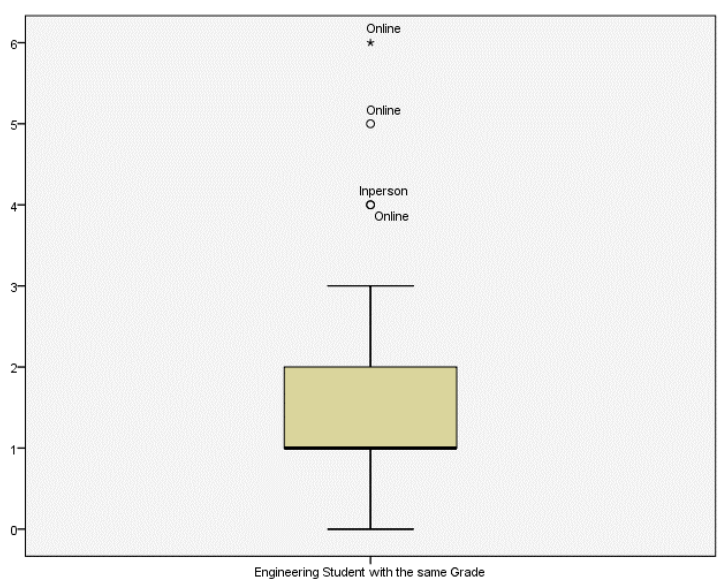
Figure 11. Box plots test for normality